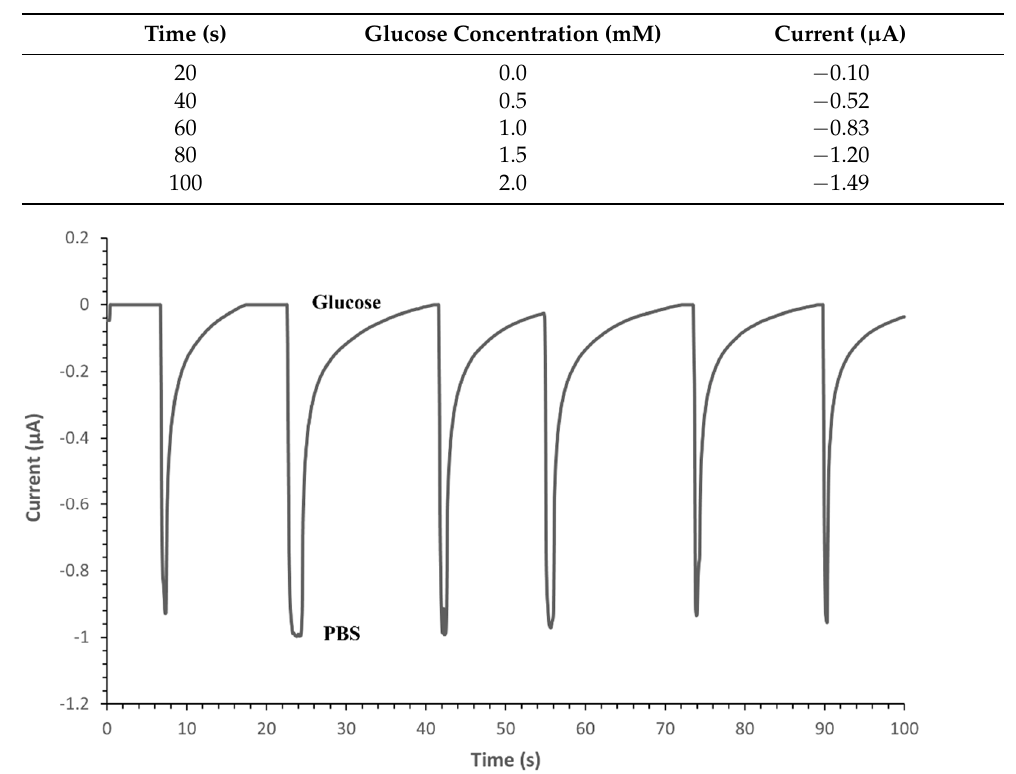
Table 1. Amperometric response to successively increasing glucose concentrations to determine the sensitivity of the 3D PMED glucose sensor.